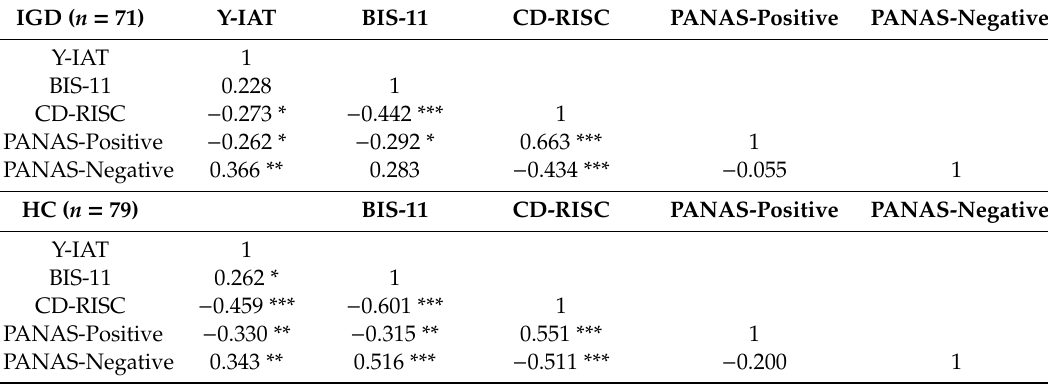
Table 2. Correlations between IGD symptoms, impulsivity, resilience, and a ff ect